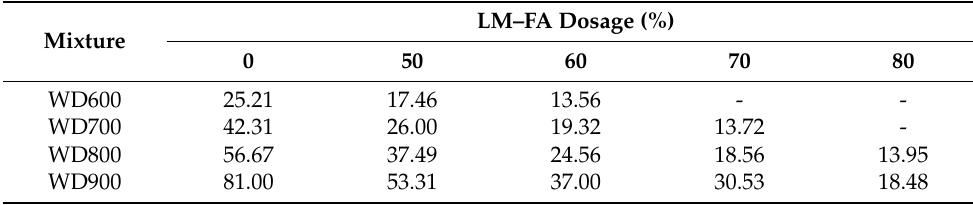
Table 8. Influence of LM–FA dosage on the CBR of mixtures.